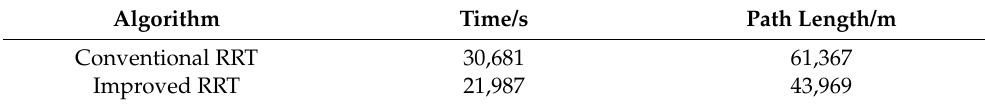
Table 5. Comparison of the search time and path lengths of the two